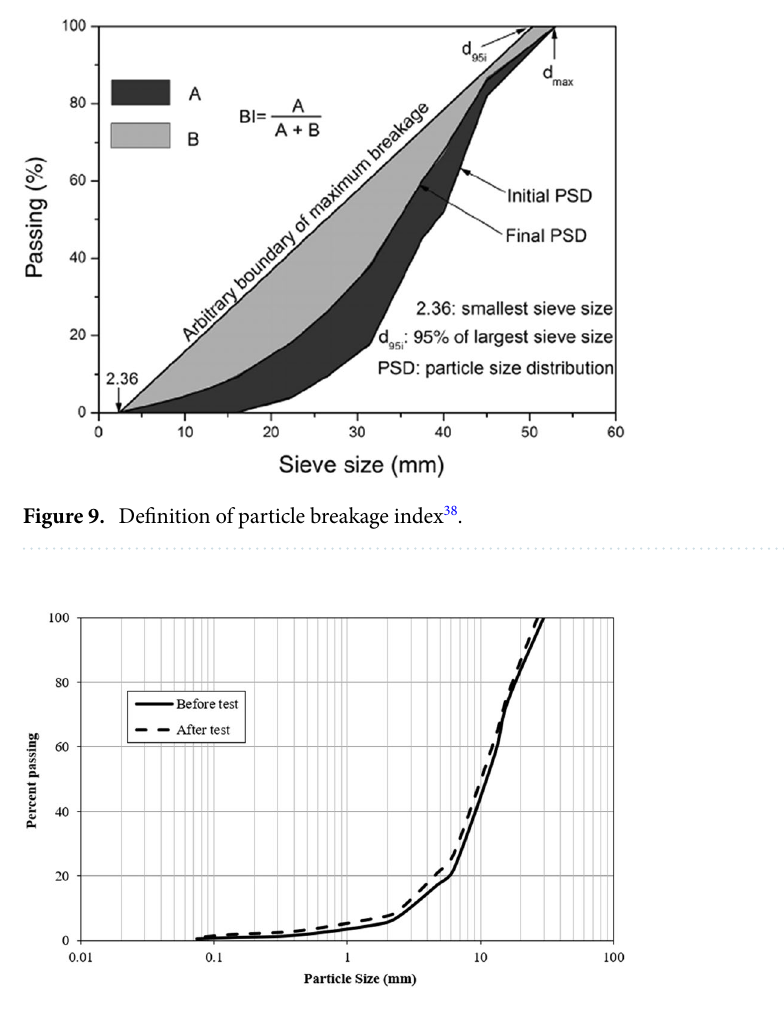
Figure 10. PSD curves before and after the direct shear test on a soil specimen with angular particles (Dry–wet test, σ n = 300 kPa).